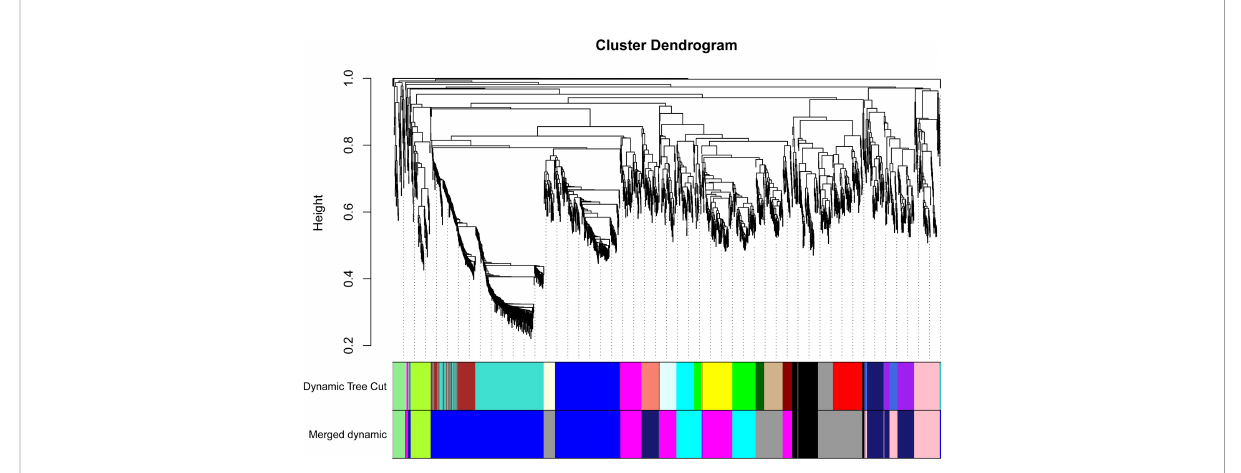
FIGURE 2 Dendrogram of all 2057 candidate genes clustered based on a dissimilarity measure (1-TOM). The minModuleSize was 30. The MEDissThres was set as 0.2. Different colors displayed the different modules. Each leaf in the tree represented one gene. The major tree branches are originally composed of 23 modules and eventually merged into 10 modules. Each color represented one module.